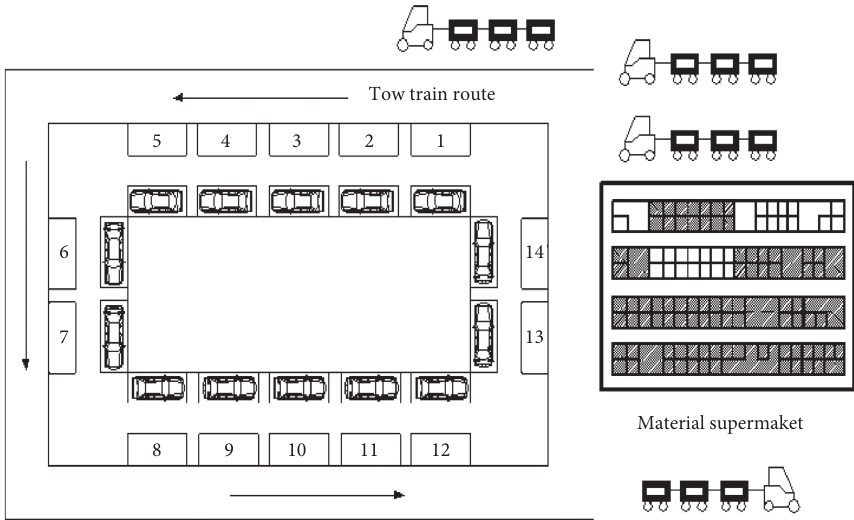
Figure 1: Layout of part supply with material